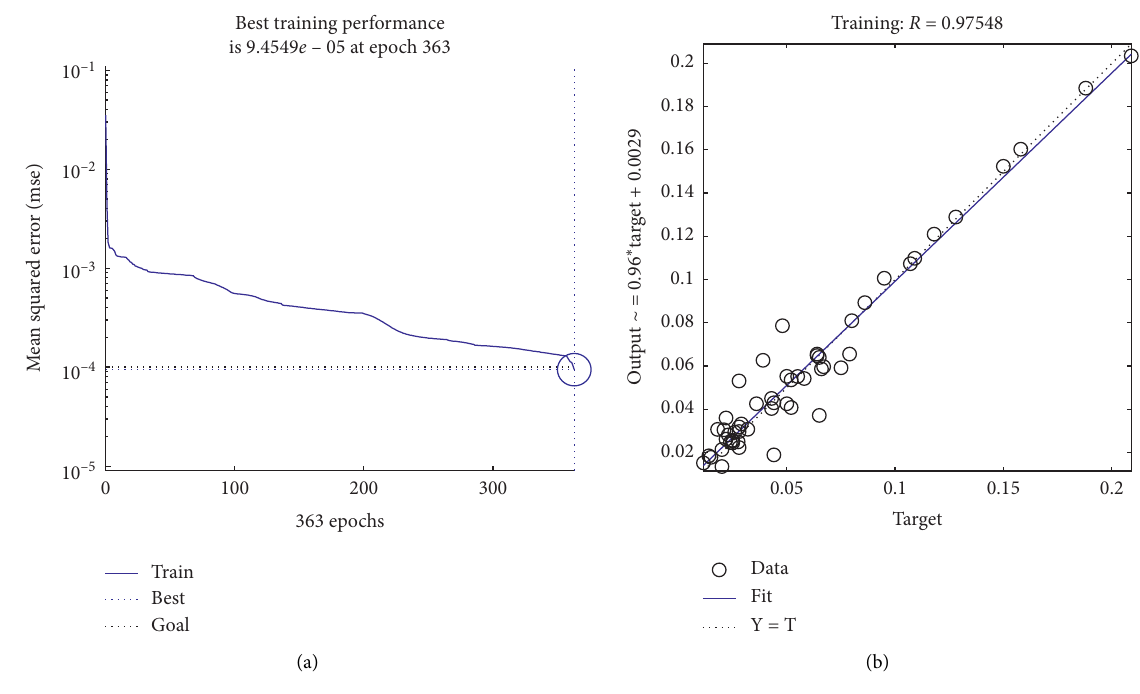
Figure 5: Training (a) performance and (b) regression.